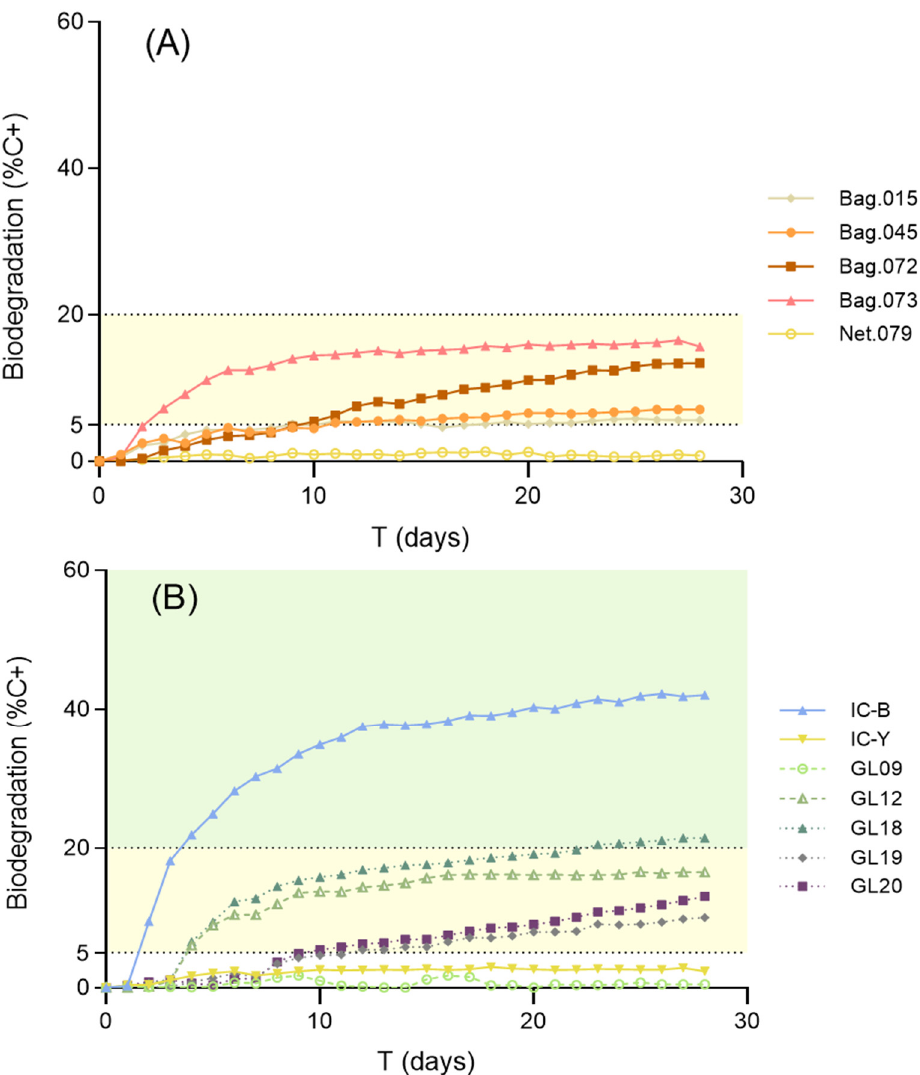
Figure 3. Results of the standard 28 day marine biodegradability test for ( A ) commercial compostable bags and ( B ) Glaukos Project first-generation polymers (GL09 and GL12), 2nd-generation polymers (GL18, GL19, and GL20), and coatings (IC-Y and IC-B). BOD data are expressed as a percentage of the reference material, PHB (%C+). All products micronized to ≤ 250 µm. Slight and moderate biodegradability are marked as yellow and green shades, respectively. Notice that the alternative coating IC-B shows remarkable marine biodegradability, and the second-generation polymer GL18 outperforms all commercial materials.